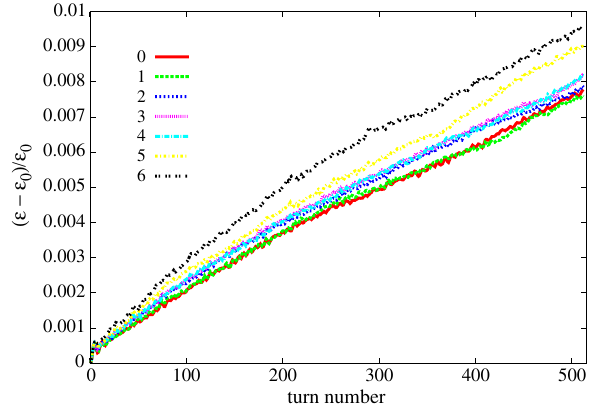
FIG. 22. Calculation of emittance growth for chromaticity values ranging from 0 to 6 in units of ξ ¼ dQ=d δ where δ is the relative energy spread in the positron beam. These calcu- lations were performed using the continuous-focusing model with a ring-averaged cloud density of 3 . 5 × 10 10 m − 3